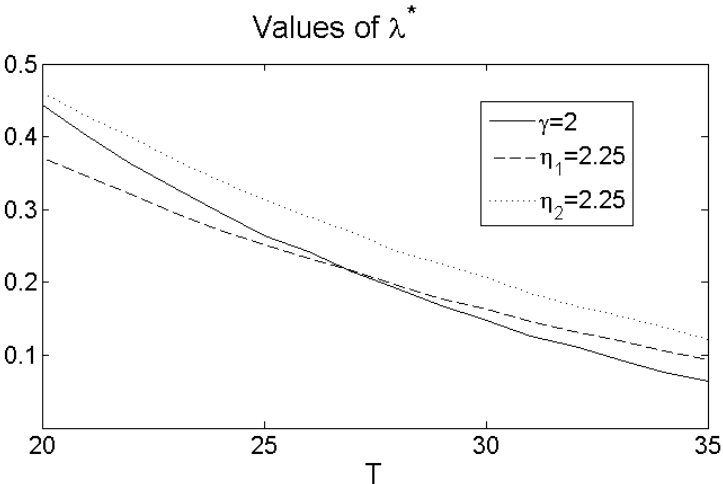
Figure 3. Values for the indifference switching λ ∗ for different levels of the career length T